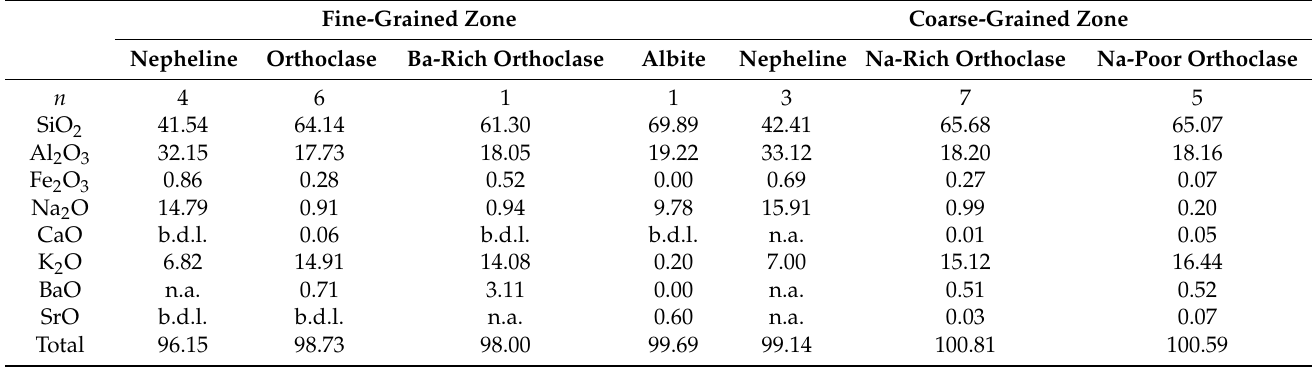
Table 1. Chemical composition (wt.%) of nepheline and feldspar. Fine-Grained Zone Coarse-Grained Zone